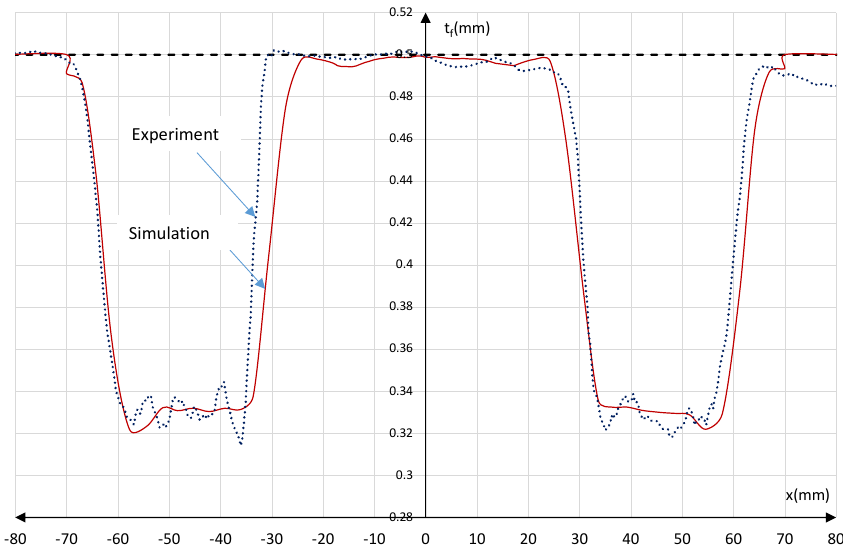
Figure 14. Experimental and FE numerical thickness distributions for depth h = 40 mm.